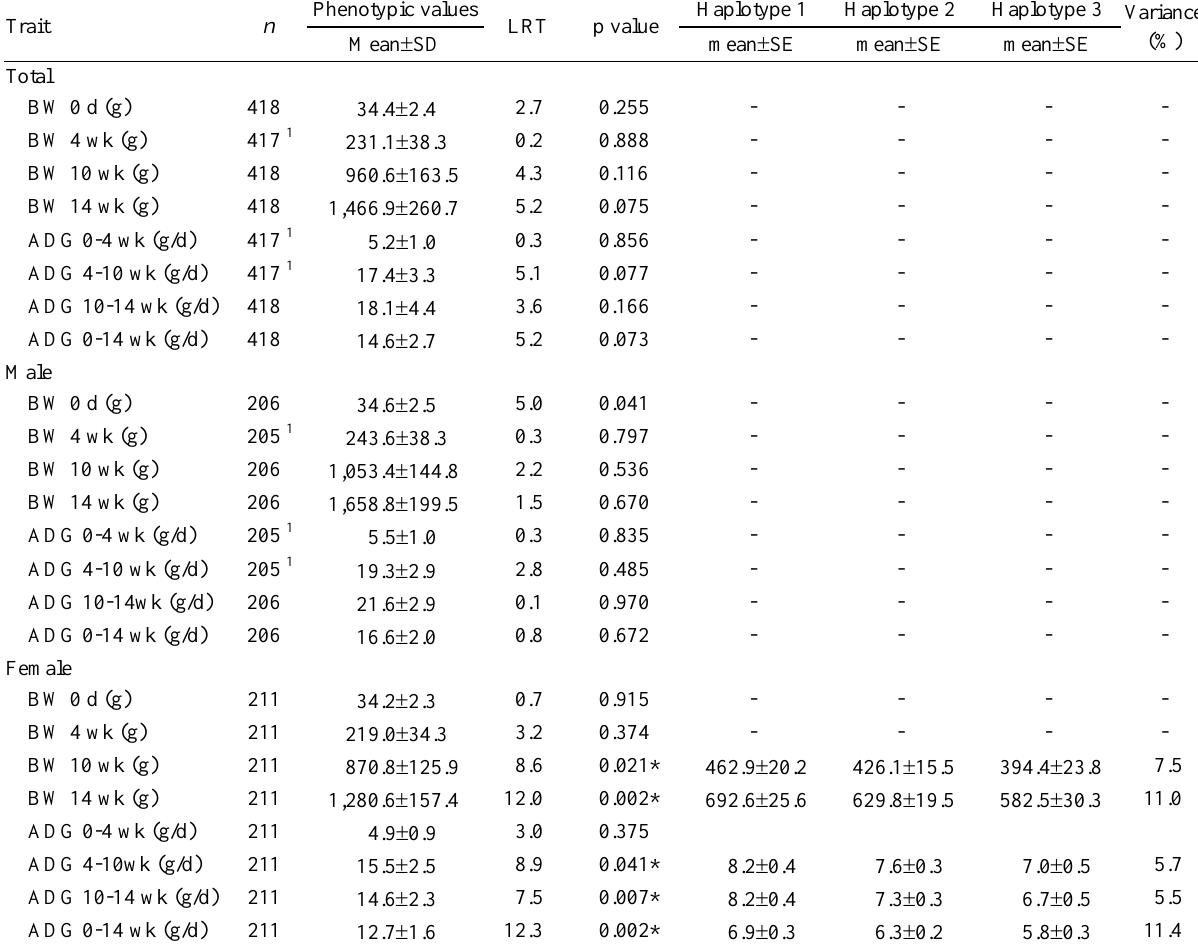
Table 4. Phenotypic values of growth traits and effects of Motilin receptor haplotypes on the traits in the F 2 population